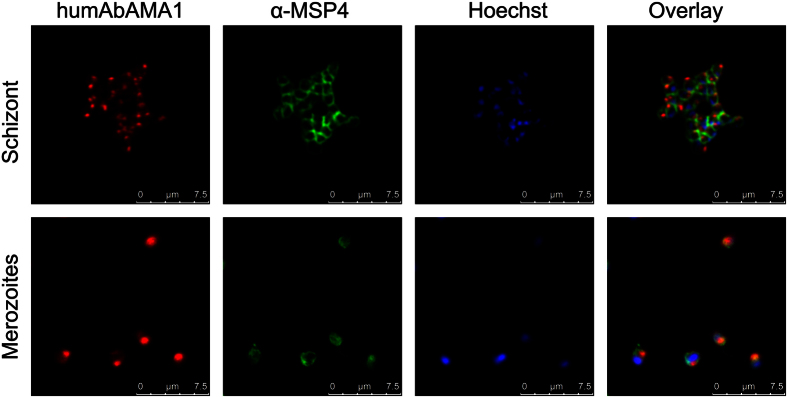
Immunofluorescence imaging of humAbAMA1.The specific binding of the recombinant antibody humAbAMA1 to both schizonts (upper panel) and free merozoites (lower panel) was analyzed by immunofluorescence assays. Parasites were co-stained with humAbAMA1 (red, first column), murine anti-MSP4 antibody (green, second column) and the nuclear stain Hoechst 33342 (blue, third column). The last column shows the overlay image. Human and murine antibodies were detected by fluorescently labelled antibodies goat-anti-human IgG (H + L)-Cy3 (Dianova) and goat-anti-mouse IgG (H + L)-Alexa Fluor® 488 (Life Technologies), respectively. Images were taken at a 630-fold magnification with a Leica TCS SP8 microscope. The right panel shows the overlay of the three fluorescence images. Scale bar 7.5 μm.